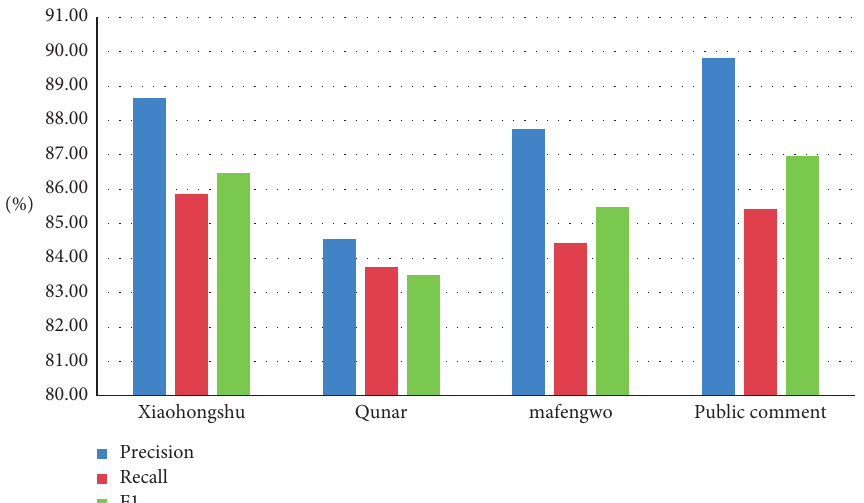
Figure 13: Comparison of Raiders’ information recommendation performance of tourism